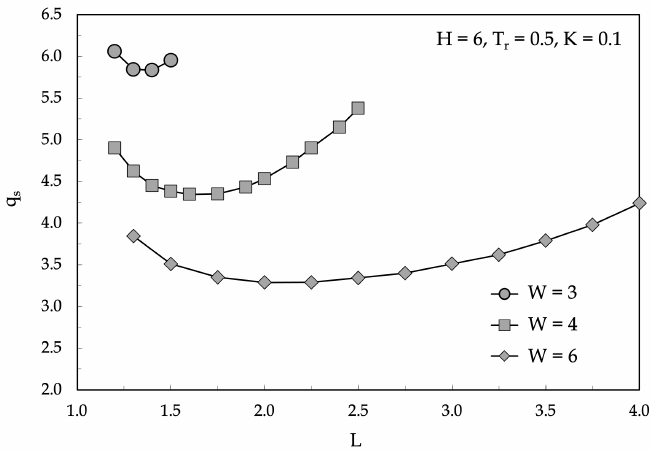
Figure 10. Distributions of the dimensionless heat loss from the supply pipe q s versus L using W as a parameter.